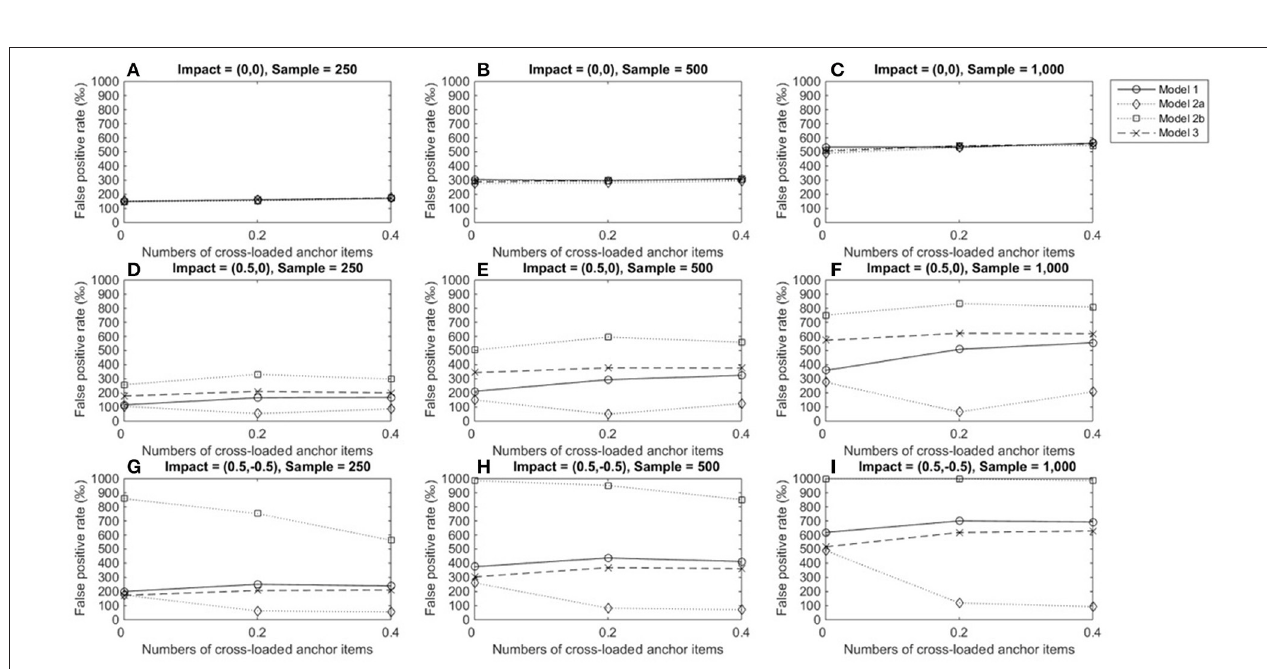
FIGURE 6 | True positive rated when the tested item measured two domain and DIF magnitude was 0.3. For model 1, total scores served as a matching variable; for model 2a, the subset score of domain 1 was used to match participants; for model 2b, the subset score of domain 2 was used to match participants; model 3 used two subset scores as matching variable. (A) Impact = (0,0), Sample = 250; (B) Impact = (0,0), Sample = 500; (C) Impact = (0,0), Sample = 1,000; (D) Impact = (0.5,0), Sample = 250; (E) Impact = (0.5,0), Sample = 500; (F) Impact = (0.5,0), Sample = 1,000; (G) Impact = (0.5, − 0.5), Sample = 250; (H) Impact = (0.5, − 0.5), Sample = 500; (I) Impact = (0.5, − 0.5), Sample = 1,000.